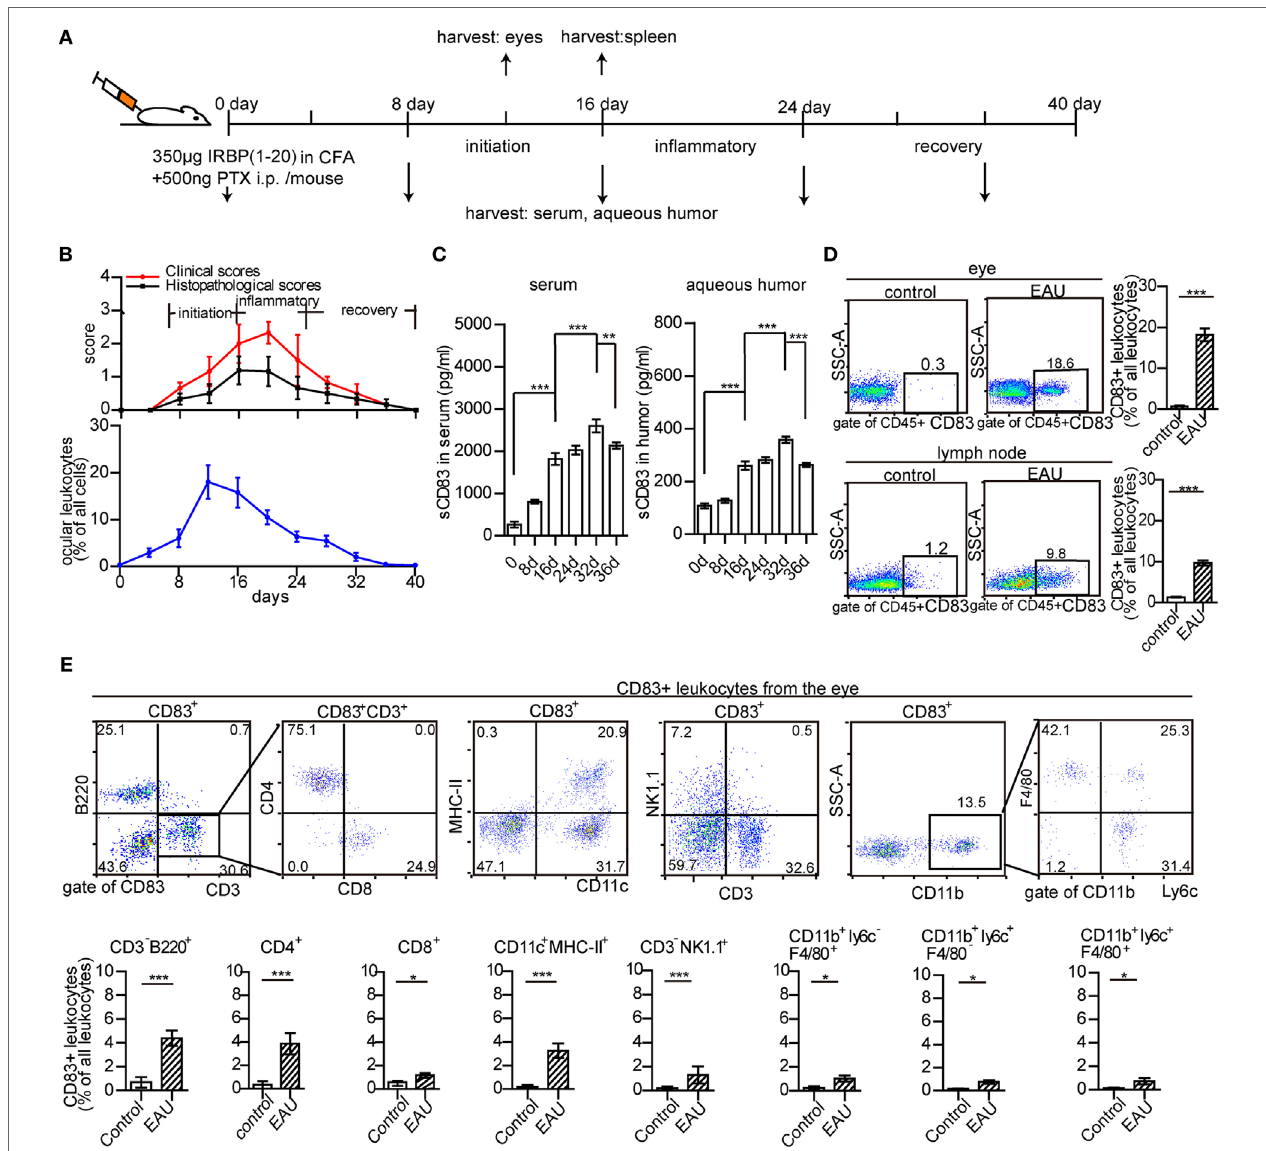
FigUre 1 | Ocular leukocyte infiltration during experimental autoimmune uveitis (EAU). (a) Protocol of EAU induction. (B) Clinical and histopathological severity score, and leukocyte infiltration in the eyes of EAU mice. (c) The concentration of soluble CD83 (sCD83) in the serum and aqueous humor. Data are shown as mean ± SEM, n = 15 in triplicates, one-way ANOVA LSD- t test. *** p < 0.001. (D) CD83 + leukocytes in inflamed eyes and drainage lymph node on day 12 post-immunization compared to controls. Gated on CD45 + cells were shown in Figure S1 in Supplementary Material. Data shown as mean ± SEM, n = 10 in triplicates, one-way ANOVA LSD- t test. *** p < 0.001. (e) Flow cytometry analysis of CD83 expression in different leukocyte subsets of the inflamed eye during EAU. Mean ± SEM, n = 10 in triplicates, two-tailed Student’s t -test. *** p < 0.001, ** p < 0.01, * p < 0.05.